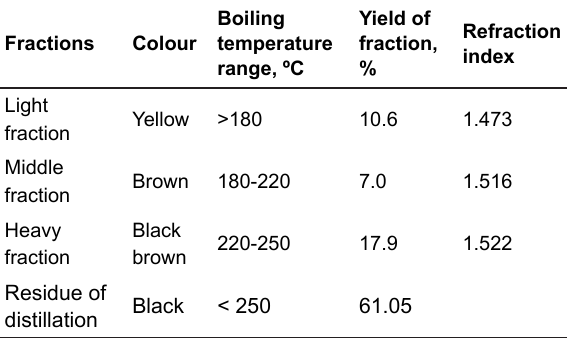
Table 11. The yields of fractions with different boiling temperature ranges